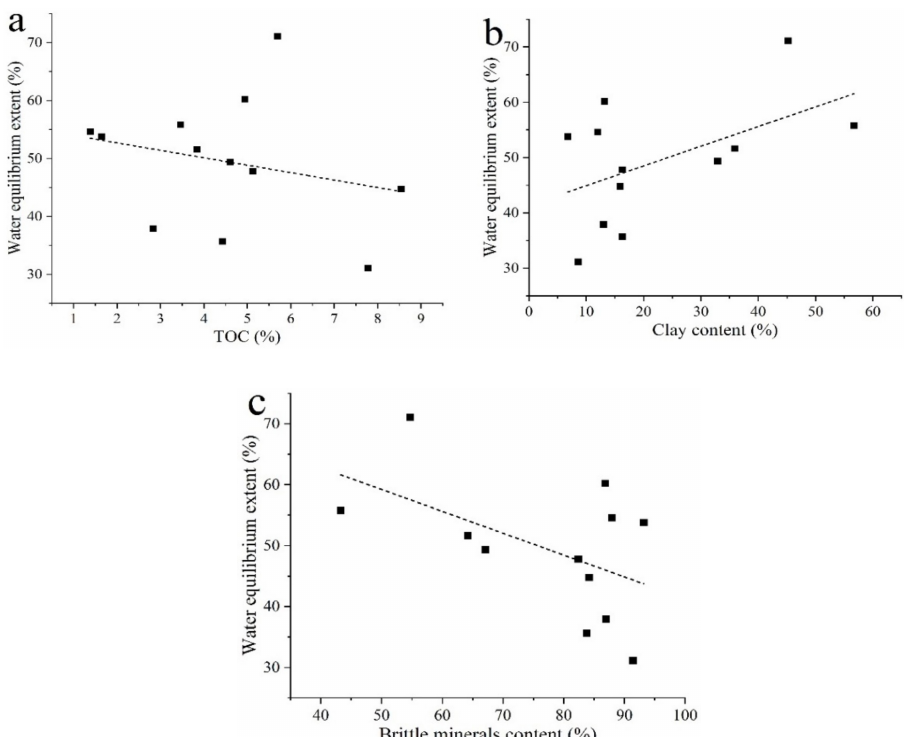
Figure 5. Relationship between water equilibrium extent and TOC ( a ), clay ( b ) and brittle mineral ( c )